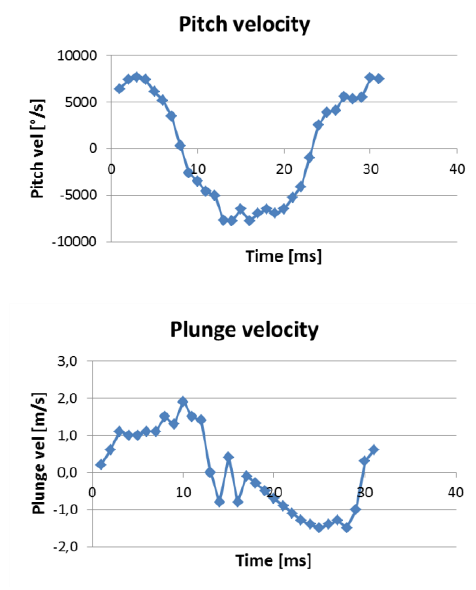
Fig. 6. Pitch velocity and plunge velocity, Ma =